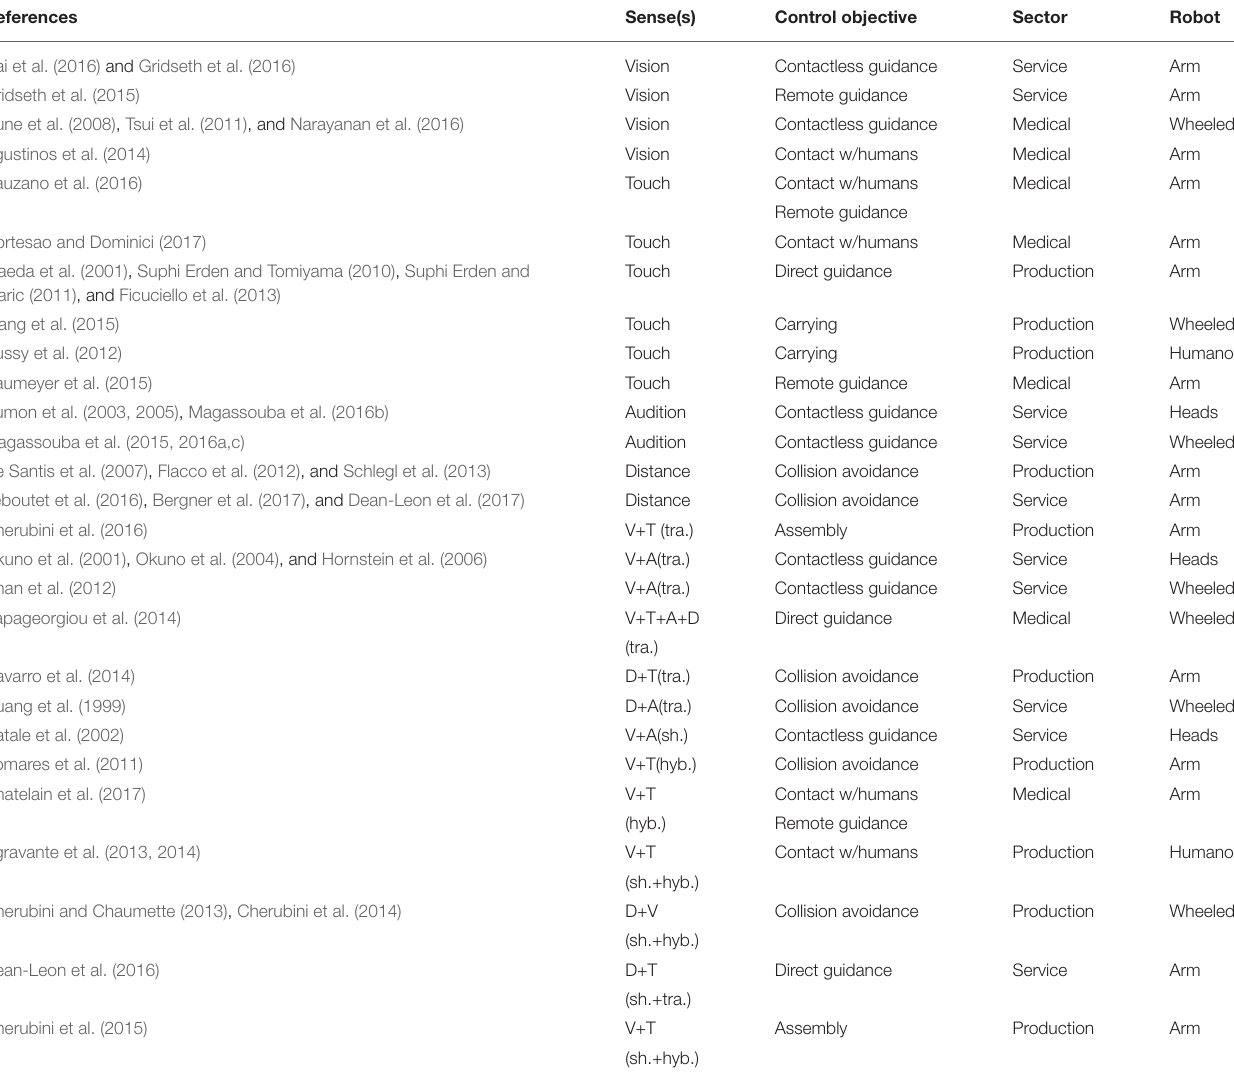
TABLE 1 | Classification of all papers according to four criteria: sense(s) used by the robot, objective of the controller, target sector, and type of